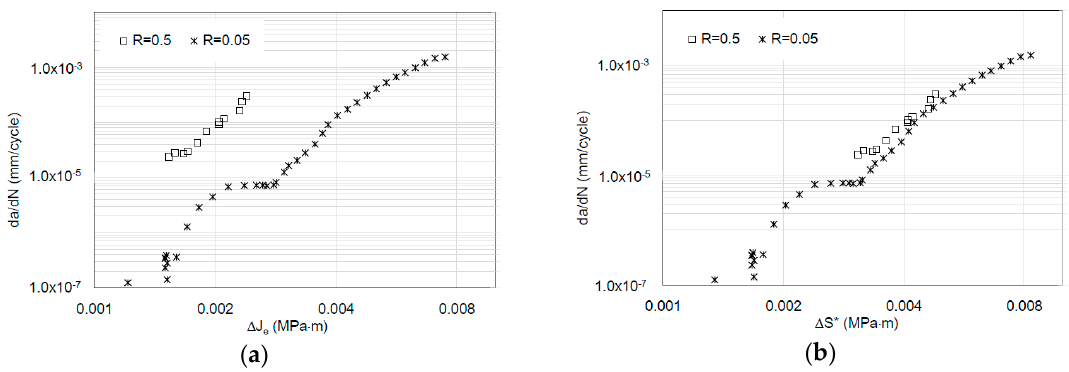
Figure 9. Fatigue crack growth curves for the puddle iron from the Eiffel bridge ( a ) based on the ∆ J crack driving force and ( b ) based on the new, averaged ∆ S* crack driving force.